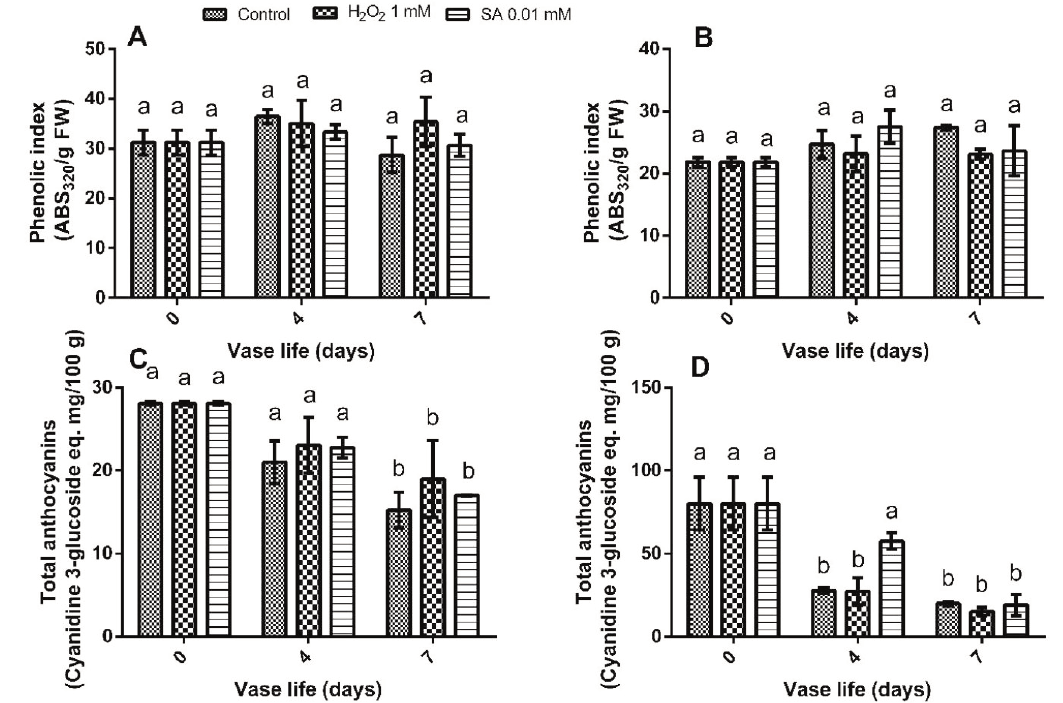
Fig. 5 - Changes in the phenolic index (A: leaves; B: petals) and in total anthocyanins levels (C: leaves; D: petals) of cut ‘Tacazzi’ rose during vase life and in response to treatments. Data are means ± SE (n=3). Different letters indicate significant differences